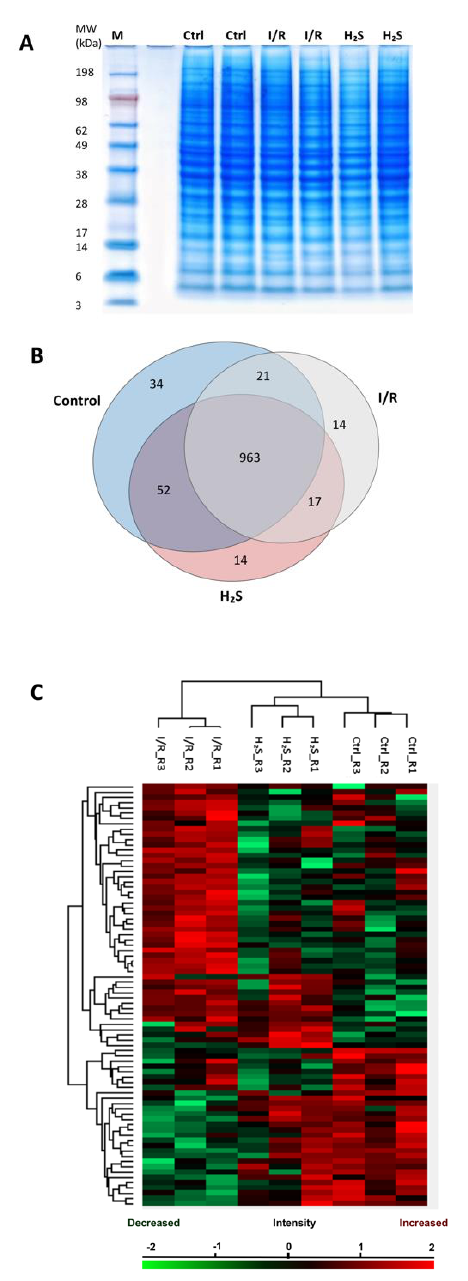
Figure 2. Retinal proteome of Ischemia-reperfusion (I / R) injured and H 2 S pre-treated retinae. ( A ) Representative retinal protein profiles of both I / R injured and H 2 S pre-treated retinae compared to non-operated retinae (designated as CTRL) resolved in PAGE gel stained with colloidal blue. M: marker. ( B ) Venn diagram depicting overlaps of identified retinal proteins in I / R injured and H 2 S pre-treated groups compared to the control group. ( C ) Heat map depicts the hierarchical clustering of the di ff erentially expressed retinal proteins in I / R injured and H 2 S pre-treated group compared to the control group, H 2 S pre-treat group demonstrated a more similar protein makeup to the control group (detailed list of proteins can also be found in Supplementary Data